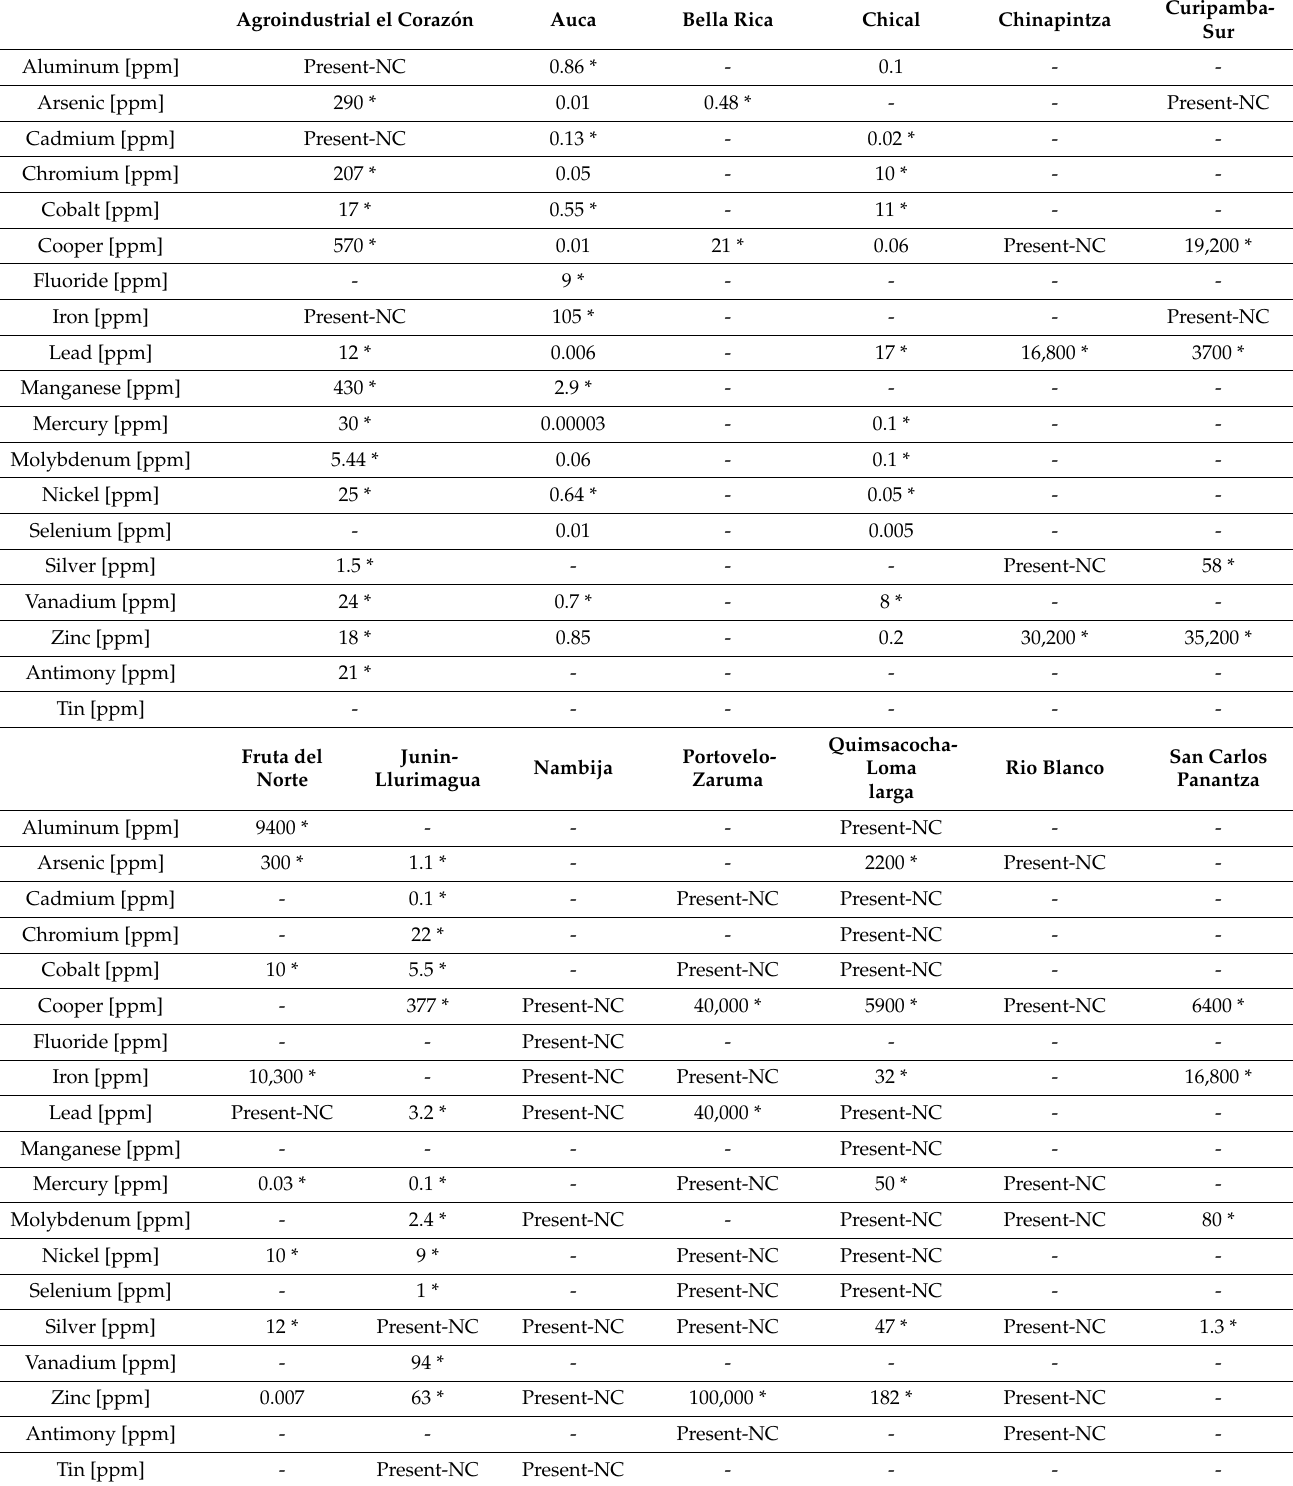
Table 3. Summary of concentrations of the studied elements in the different deposits. Present-NC indicates that qualitative information of presence was found, but no details of specific concentration. An * indicates the concentration exceeds the WHO [73] safety